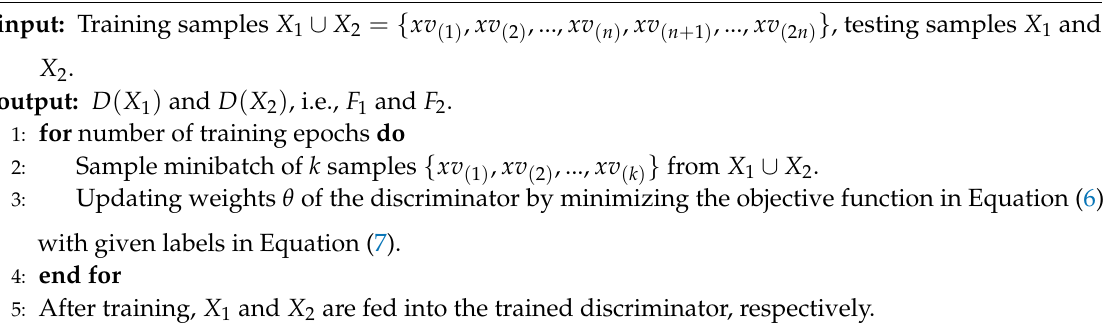
Algorithm 1 Learning Procedure in